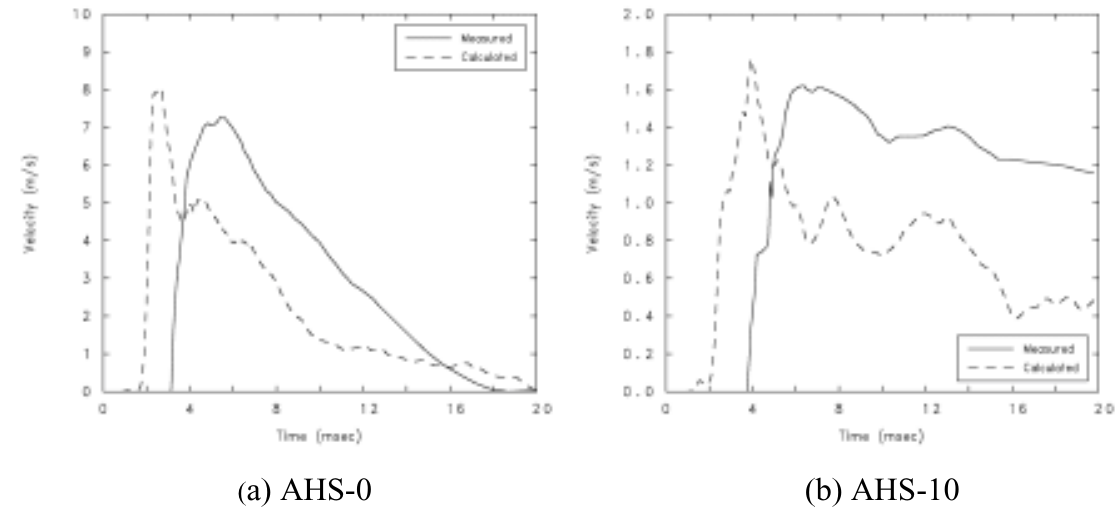
Fig. 11. Velocity at accelerometer locations AHS-0 and AHS-10, test